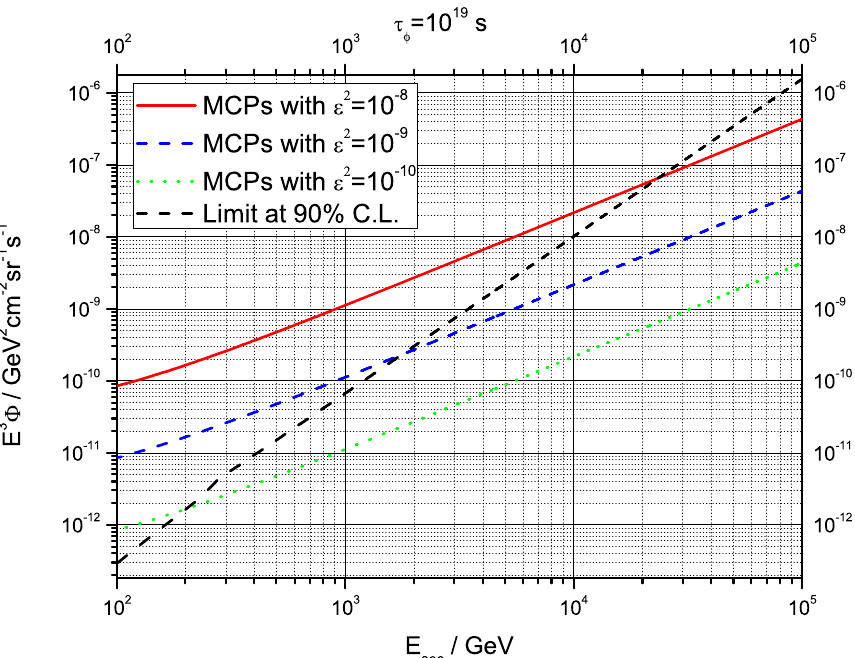
Figure 3 . With the different (cid:15) 2 (= 10 − 10 , 10 − 9 and 10 − 8 ), the fluxes of expected MCPs were estimated at IceCube, respectively. Assuming no observation at IceCube in 6 years, the upper limit at 90% C.L. was also computed.